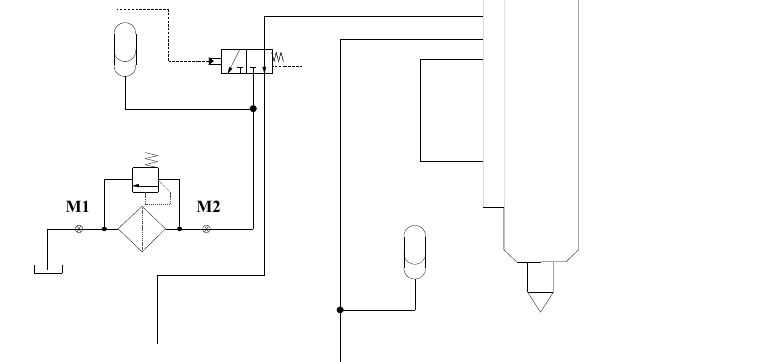
Figure 12 – Measuring points in the filter block of the hydraulic hammer system return line